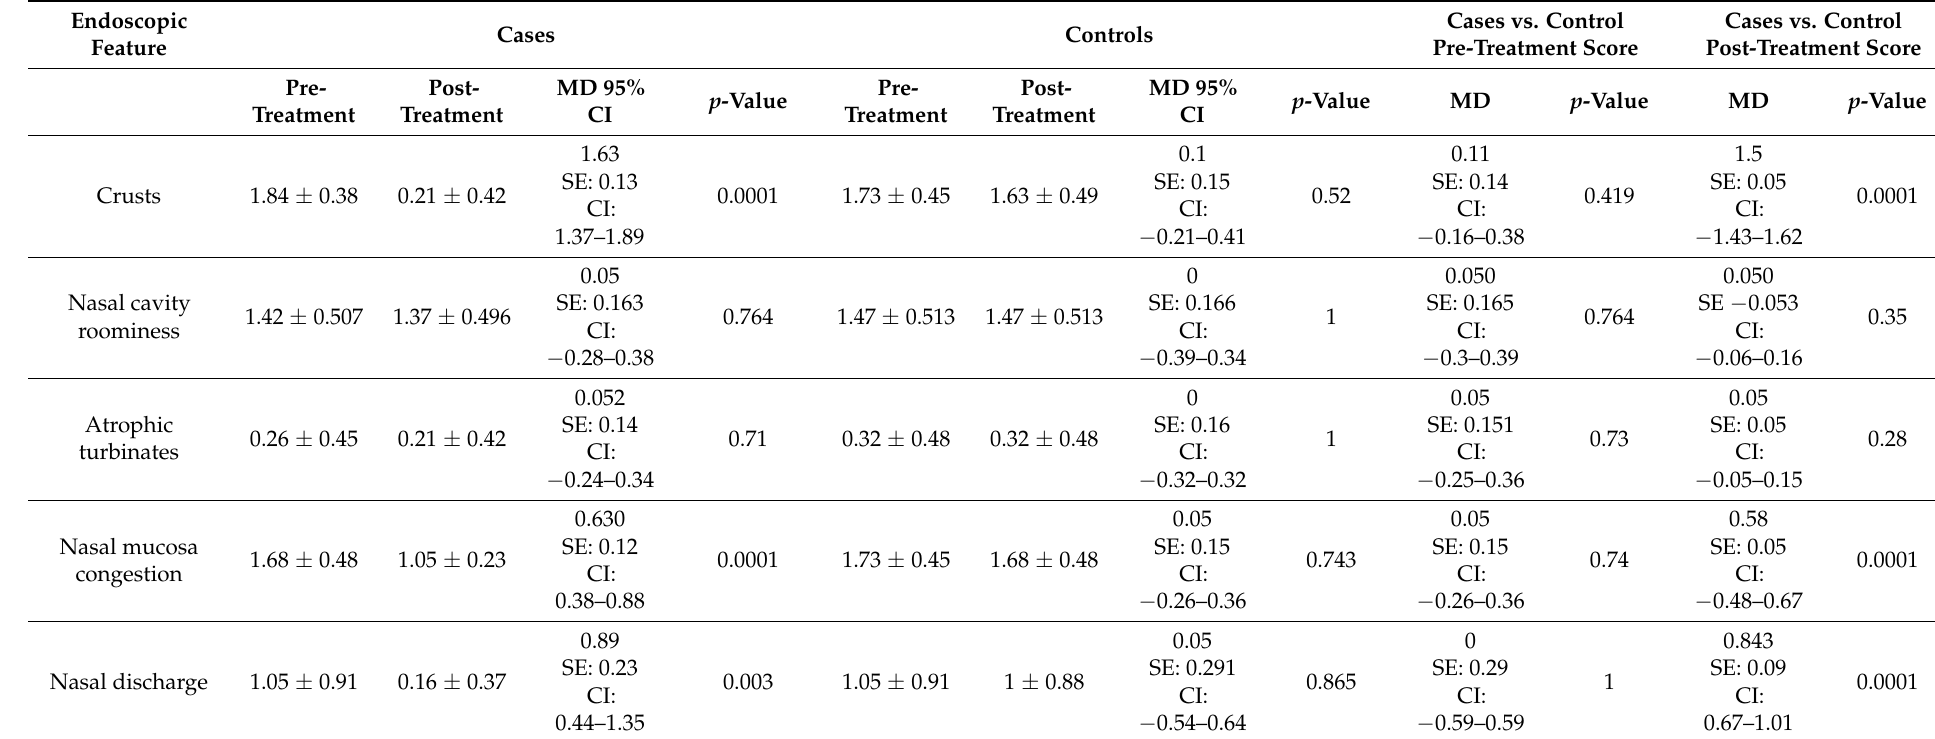
Table 2. Endoscopic scores pre- and post-treatment compared between the right (test) and left (control)